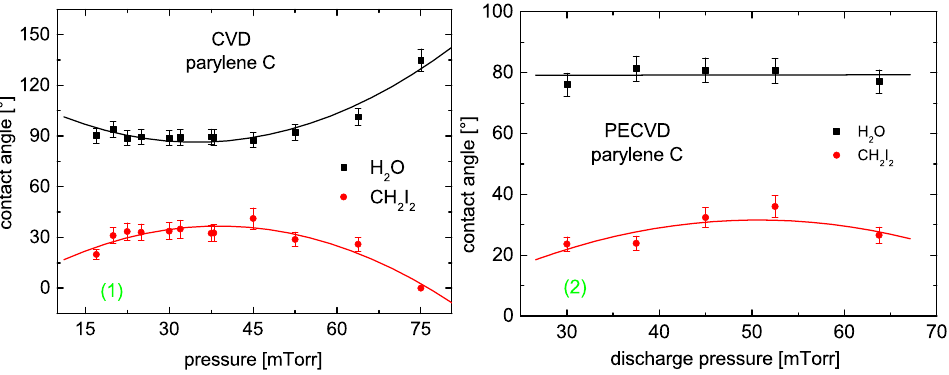
Figure 24. Different shape of the contact angle for CVD parylene C ( 1 ) and PECVD parylene C ( 2 ). CVD parylene is significantly more hydrophobic than PECVD